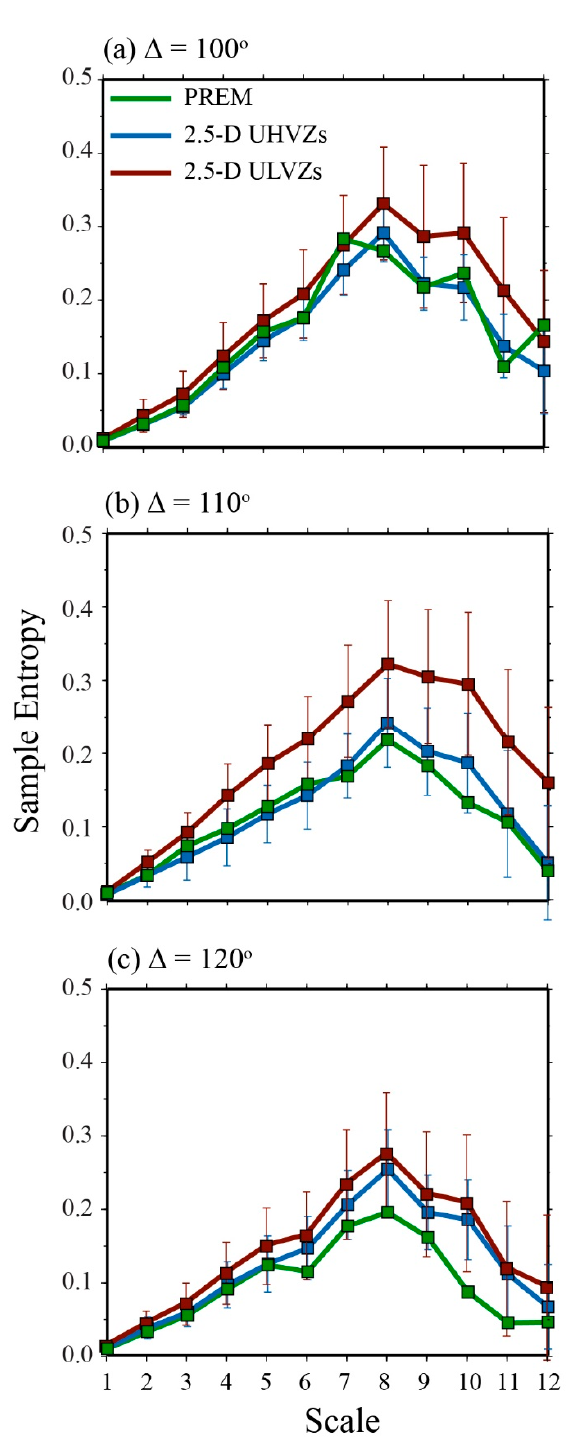
Figure 15. Multiscale sample entropy for PREM (green), all 2.5-D UHVZ models (blue), and all 2.5- D ULVZ models (red) for which the edge ( l ) is ≥ 11.0°. Shown are measurements at epicentral ULVZ models (red) for which the edge ( l ) is ≥ 11.0 ◦ . Shown are measurements at epicentral distances distances of ( a ) 100°, ( b ) 110°, and ( c ) 120°. Standard deviation of all models at each scale is indicated of ( a ) 100 ◦ , ( b ) 110 ◦ , and ( c ) 120 ◦ . Standard deviation of all models at each scale is indicated with the with the error bars. error